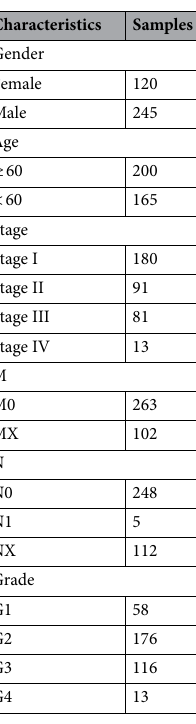
Table 1. Clinical characteristics of 365 HCC patients in